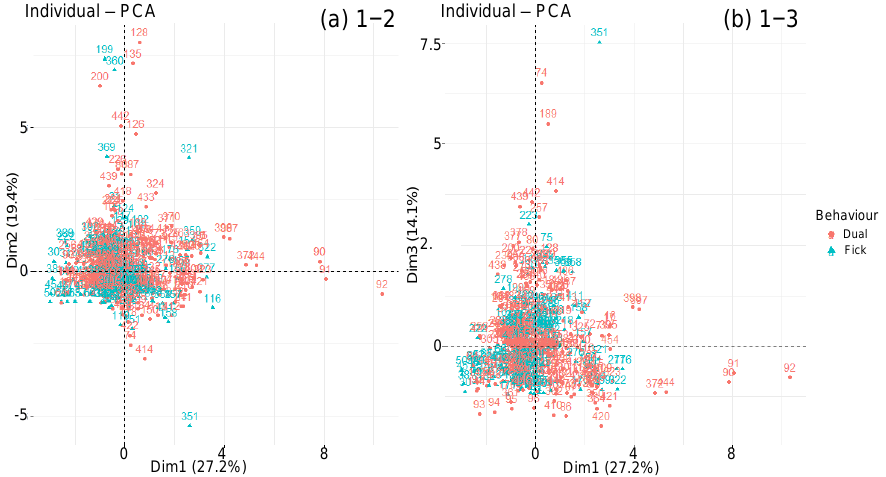
Figure 9. Graphs of individuals on planes ( a ) 1–2 and ( b ) 1–3 of the global PCA, according to diffusion